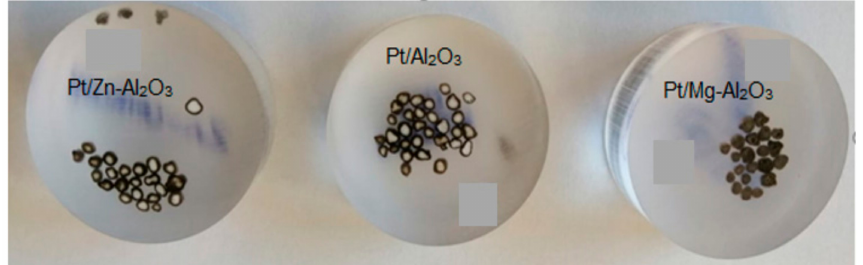
Figure 13. Exposed cross-sectional areas of catalysts, for scanning electron microscopy-energy dispersive X-ray spectroscopy (SEM-EDS) line